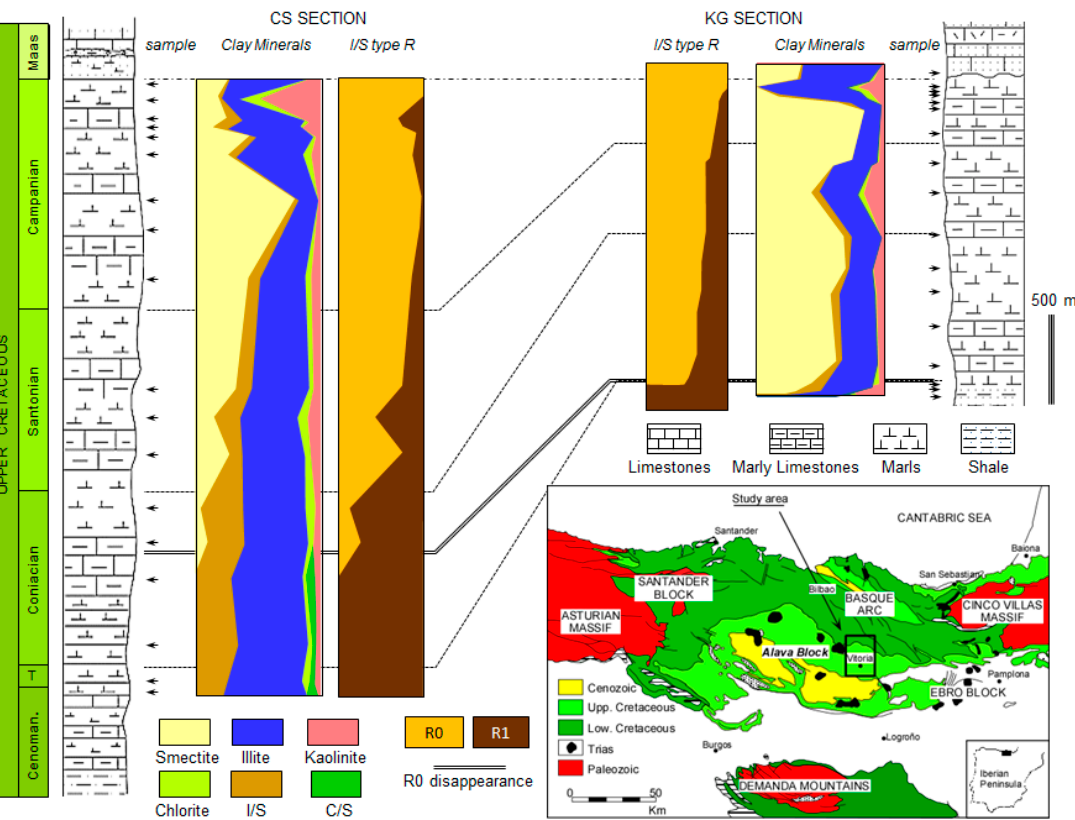
Figure 1. Stratigraphic correlation of the studied series and variations in the clay mineralogy with burial depth. The geologic map of the Basque-Cantabrian basin showing the location of the studied area is modified of Arostegui et al. [22].